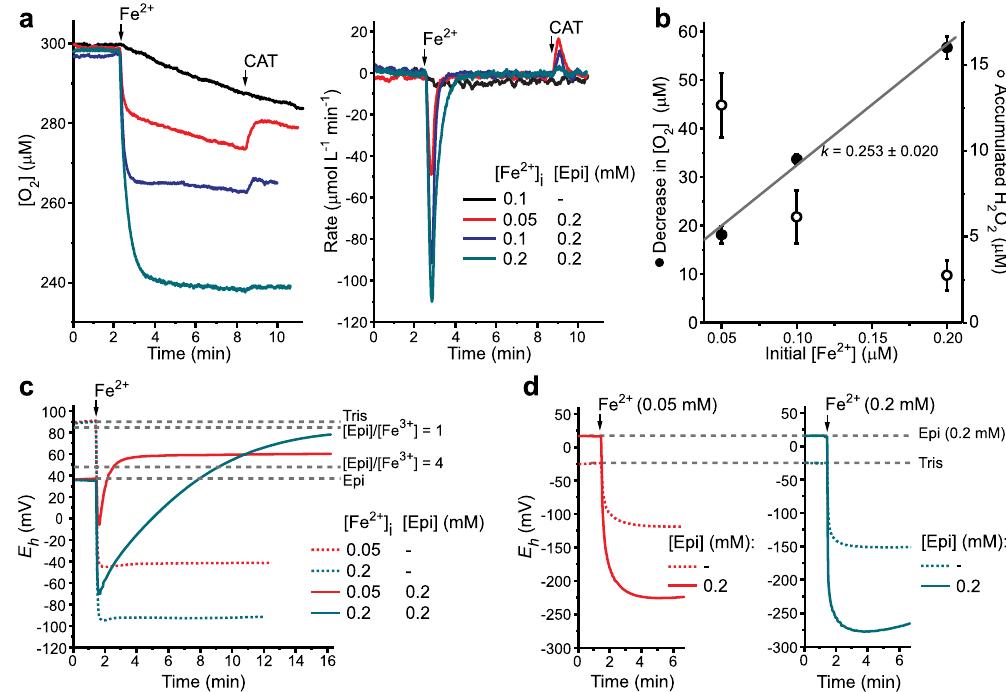
Figure 6. Changes in O 2 concentration and redox potential ( E h ) in Epi/Fe 2 + systems in 10 mM Tris, pH 7.4. ( a ) Changes of [O 2 ] and rate of O 2 consumption induced by different concentrations of Fe 2 + in the absence or presence of 0.2 mM Epi. Top-down peaks in the right panel represent the initial rate of O 2 consumption following the addition of Fe 2 + . ( b ) Quantification of O 2 consumption and H 2 O 2 accumulation, 30 s after the addition of Fe 2 + or CAT, respectively. H 2 O 2 accumulation was quantified by CAT-induced O 2 release (2H 2 O 2 → 2H 2 O + O 2 ; [H 2 O 2 ] = 2 × Δ [O 2 ]). Data are presented as means ± SE. Closed circles represent [O 2 ] and open circles represent [H 2 O 2 ]. ( c ) Changes in the redox potential of 10 mM Tris buffer with or without Epi, following the addition of Fe 2 + . ( d ) Changes in the redox potential of O 2 -free 10 mM Tris buffer (under N 2(g) ) with or without Epi, following the addition of Fe 2 + . Dashed lines denote the redox potentials of referent systems (stable over